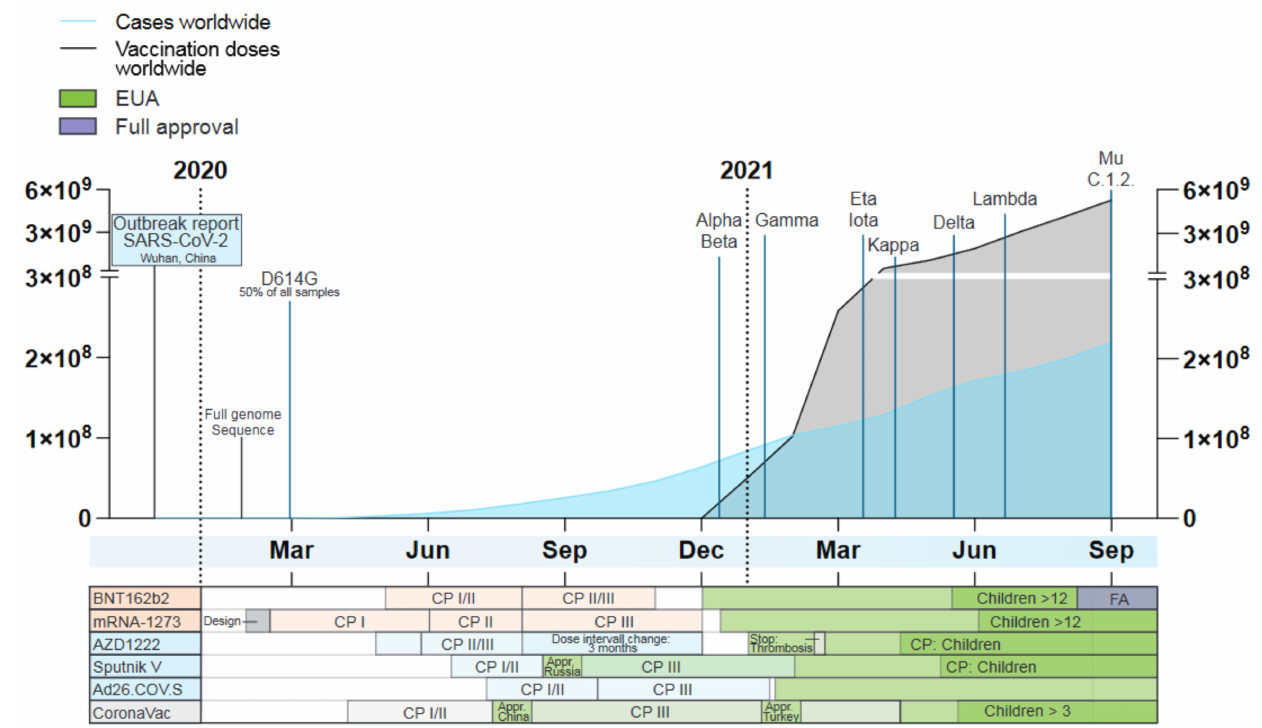
Figure 2. Timeline of the number of worldwide detected SARS-COV-2 cases (blue) and administered vaccination doses (grey), the time point of designation as a VOC or VOI by the WHO as well as key dates during the development of currently approved vaccines based on their technology: mRNA vaccines (orange), adenovirus-based vaccines (blue) and recombinant protein vaccines (grey). Given is the timeframe from the outbreak report of SARS-CoV-2 by the WHO in December 2019 until September 2021. Data taken from ‘Our world in data’ (September 2021) [104]. CP = clinical phase, Appr. = Approval, EUA = emergency use authorization, FA = Full